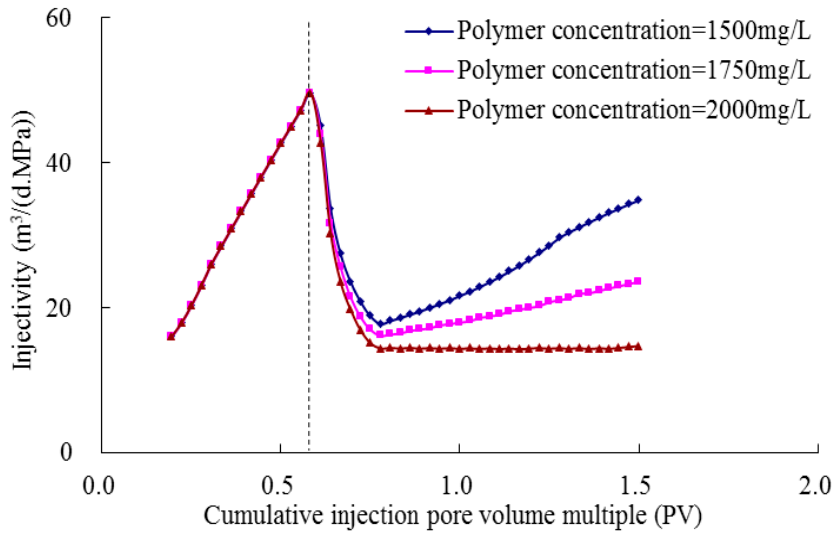
Figure 13. The influence of polymer concentration on injectivity.